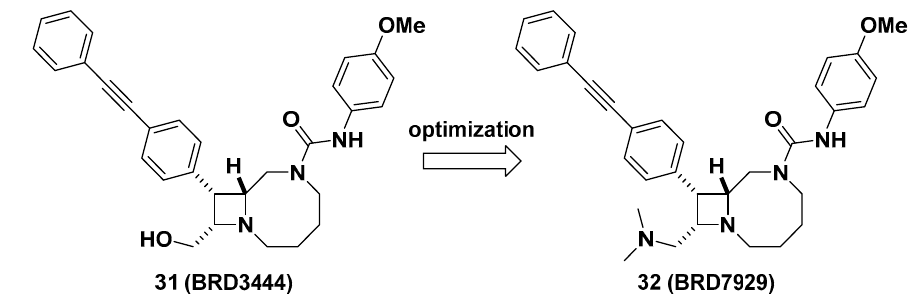
Figure 12. BRD7929, a potent inhibitor of Pf PheRS for malaria.